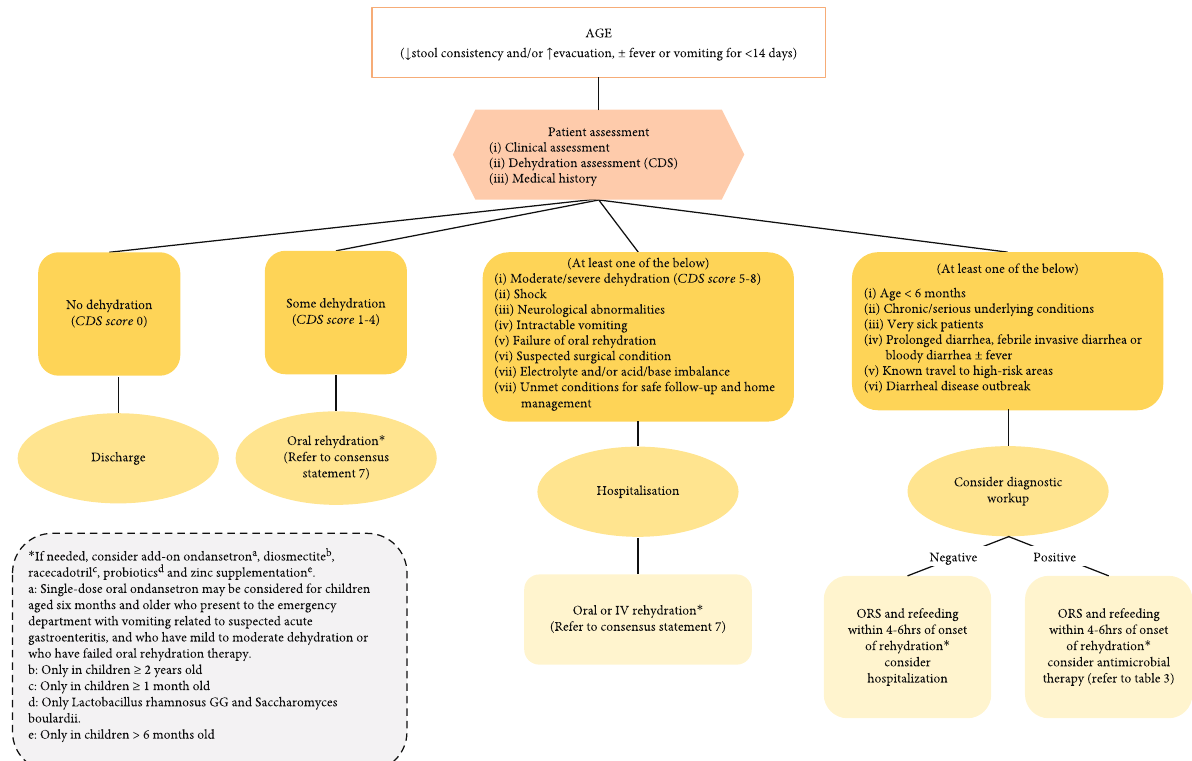
Figure 1: Treatment algorithm for paediatric AGE in Jordan. AGE: acute gastroenteritis; CDS: Clinical Dehydration Scale; IV: intravenous; ORS: oral rehydration